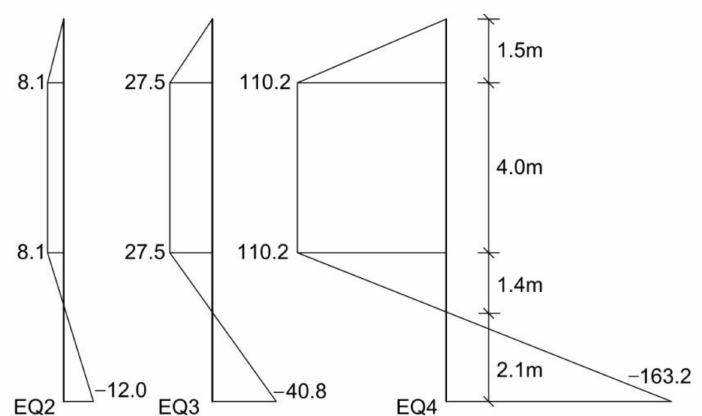
Figure 19. Simplified distributed load increment above the slip surface after each shaking event (unit: